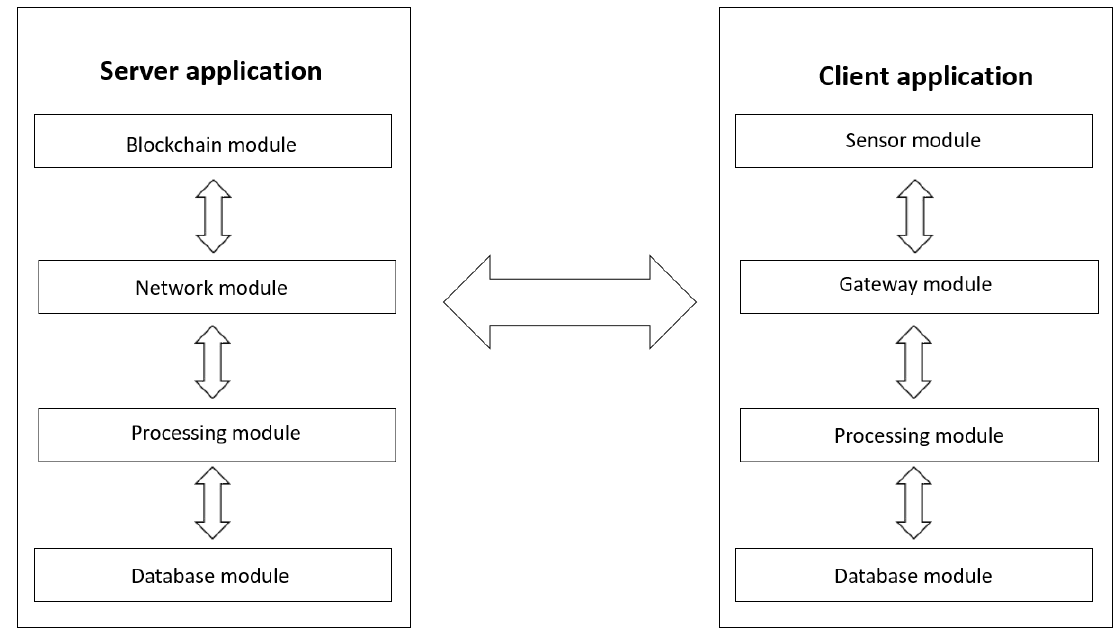
Figure 2. System